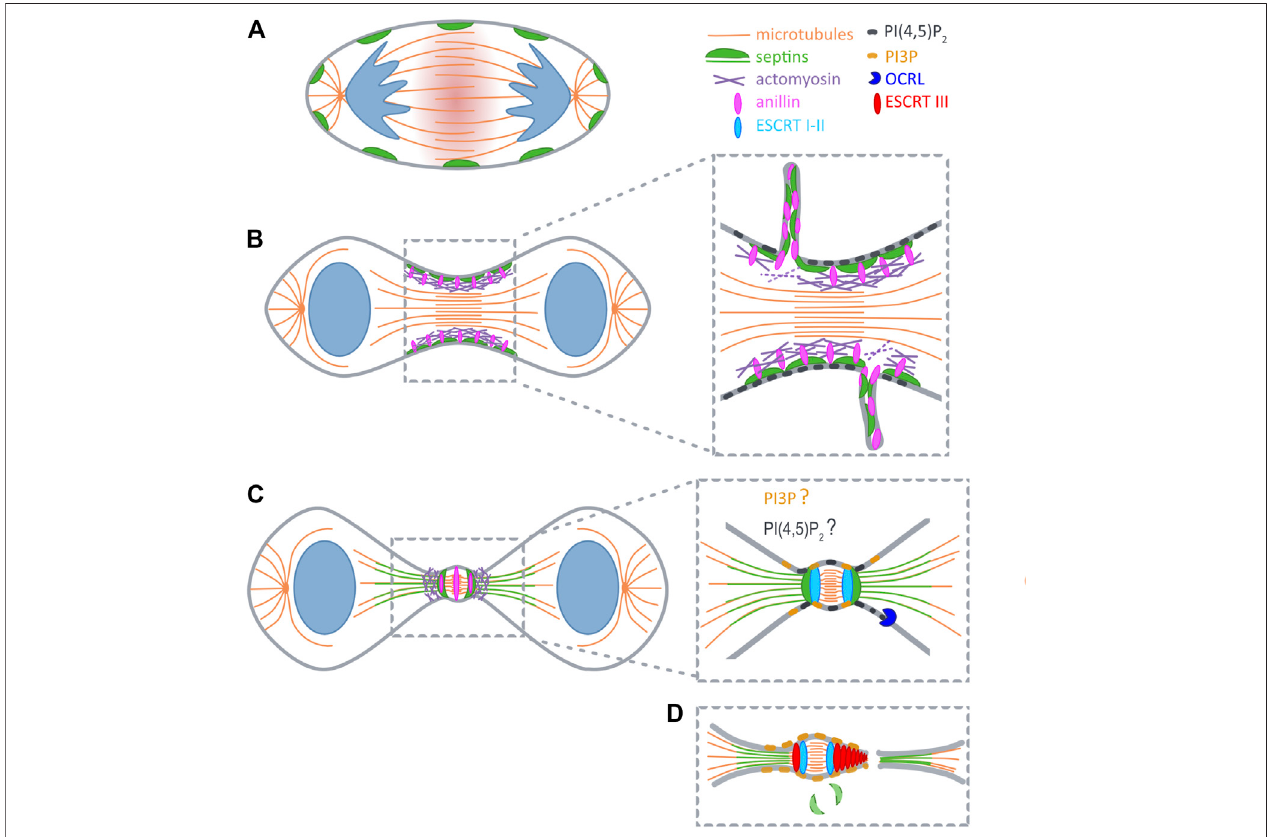
FIGURE 1 | Septins during cytokinesis. (A) At anaphase RhoA is activated at the midzone (red shadow). (B) At early telophase septins (green) are recruited to furrow by anillin (pink), and during furrow constriction promote extrusion of plasma membrane tubules. (C) After ingression septins reorganize into a double ring and support the formation of secondary ingression sites by dictating the relocalization of anillin and actomyosin (purple). At the same time SEPT9 locally activates Tsg101 (light blue). Initial recruitment of ESCRTI to the midbody is not depicted for clarity reasons. (D) Recruitment of ESCRTIII (red) occurs concomitantly with the disappearance of septin double rings. PI(4,5)P 2 (dark grey) builds up early at the cleavage furrow, and might also become concentrated at the midbody ring. PI(4,5)P 2 is hydrolyzed upon arrival of OCRL (blue) at the ICB. Prior to abscission a pool of PI(3)P (yellow) is generated at the midbody that likely supports ESCRT assembly.